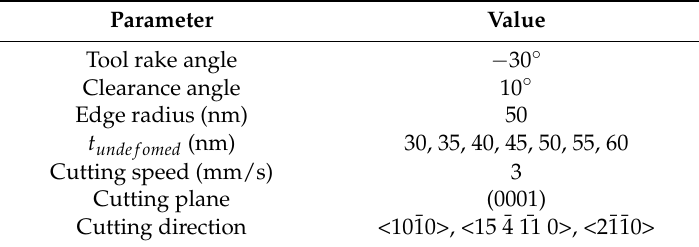
Table 3. Cutting parameters adopted in the FEM modelling.